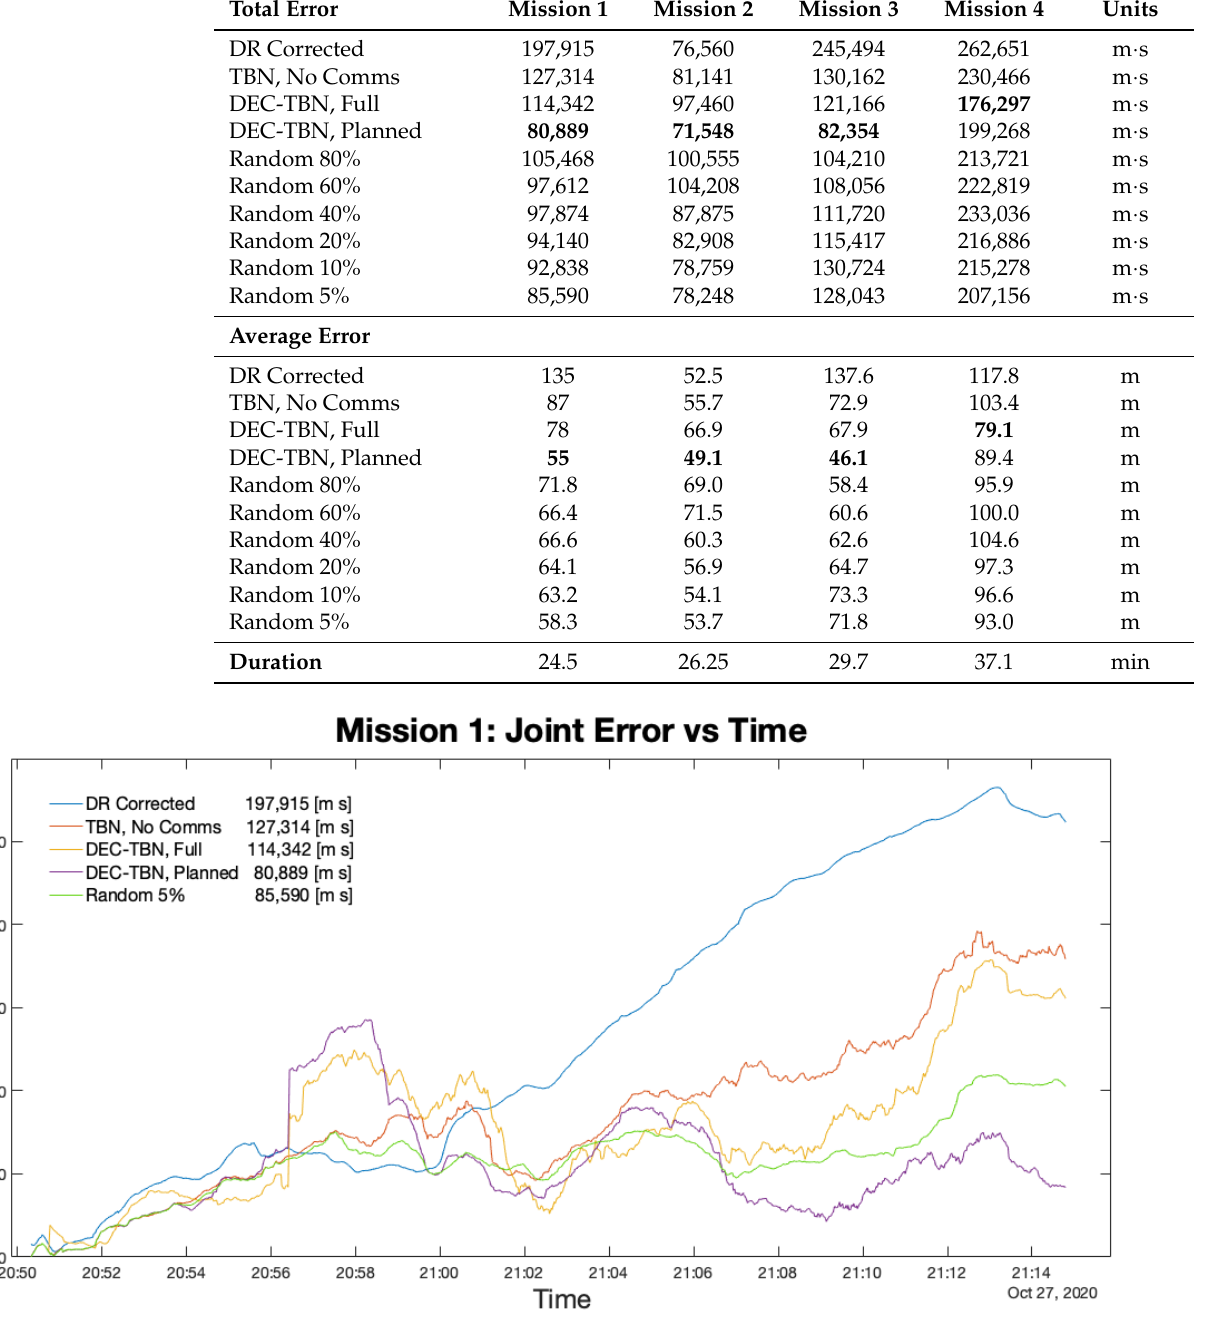
Figure 12. Joint Error for Mission 1. This figure shows that the planning algorithm enabled better localization accuracy. Only one communication was used by the